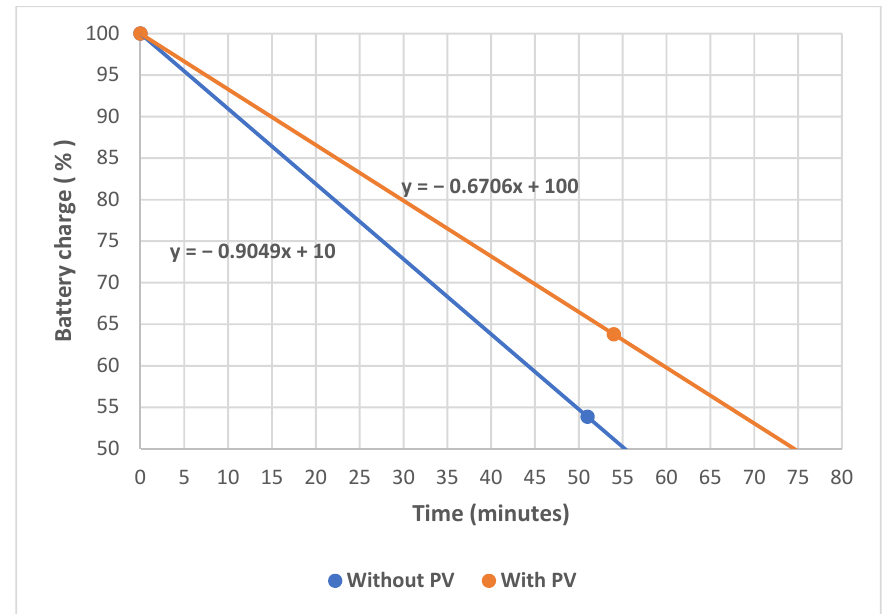
Figure 12. Ba tt ery discharge slopes for EVs with and without PV. Figure 12. Battery discharge slopes for EVs with and without